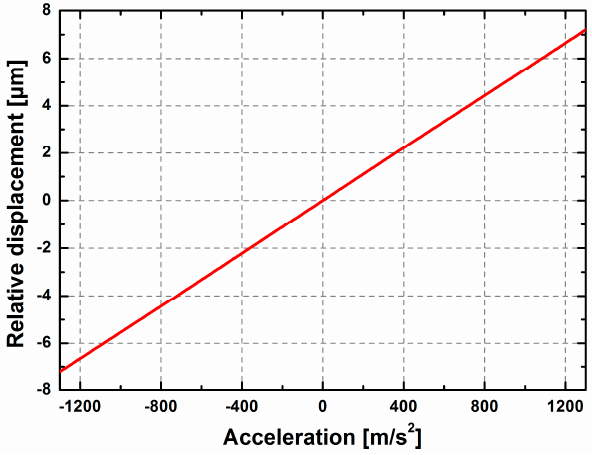
Figure 9. Relationship between the relative displacement and the applied acceleration.